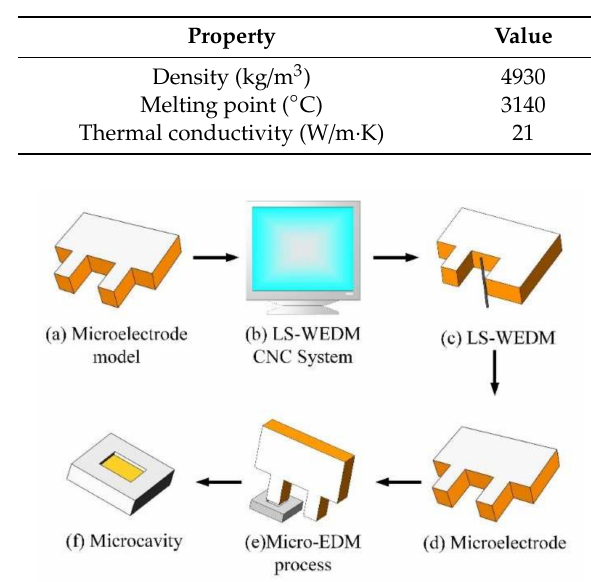
Table 4. Physical properties of TiC.